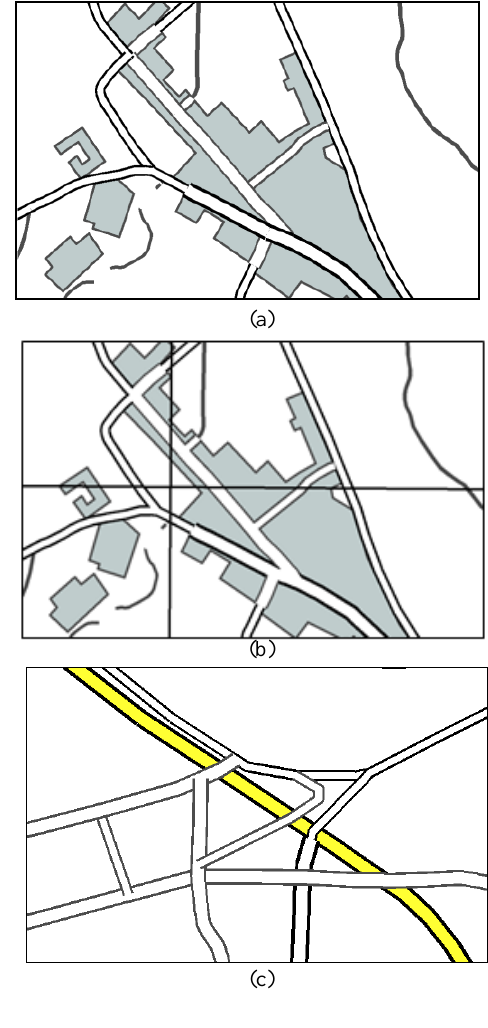
Fig.12 Feature-level organization in water area layer The experiment of feature-level organization is also carried out in road layer. It refers to both feature priority and symbol integration. The feature priority of road layer is listed in the table above, shows different grades of roads. The symbol integration set to roads keep the connectivity of roads. Fig.13 (a) and (b) are the contrast before and symbol integration. And (c) and (d) add set of feature priority to the contrast of symbol integration. The yellow road has higher priority than other roads, so it was drawn overpass others. And all intersects of roads have been merged by symbol integration to realize the connectivity of